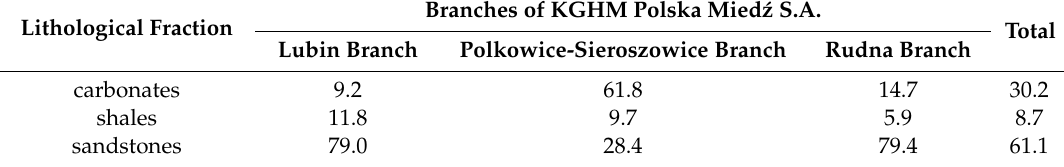
Table 2. Proportion of lithological types in the material mined in the KGHM Polska Mied´z S.A. Mining